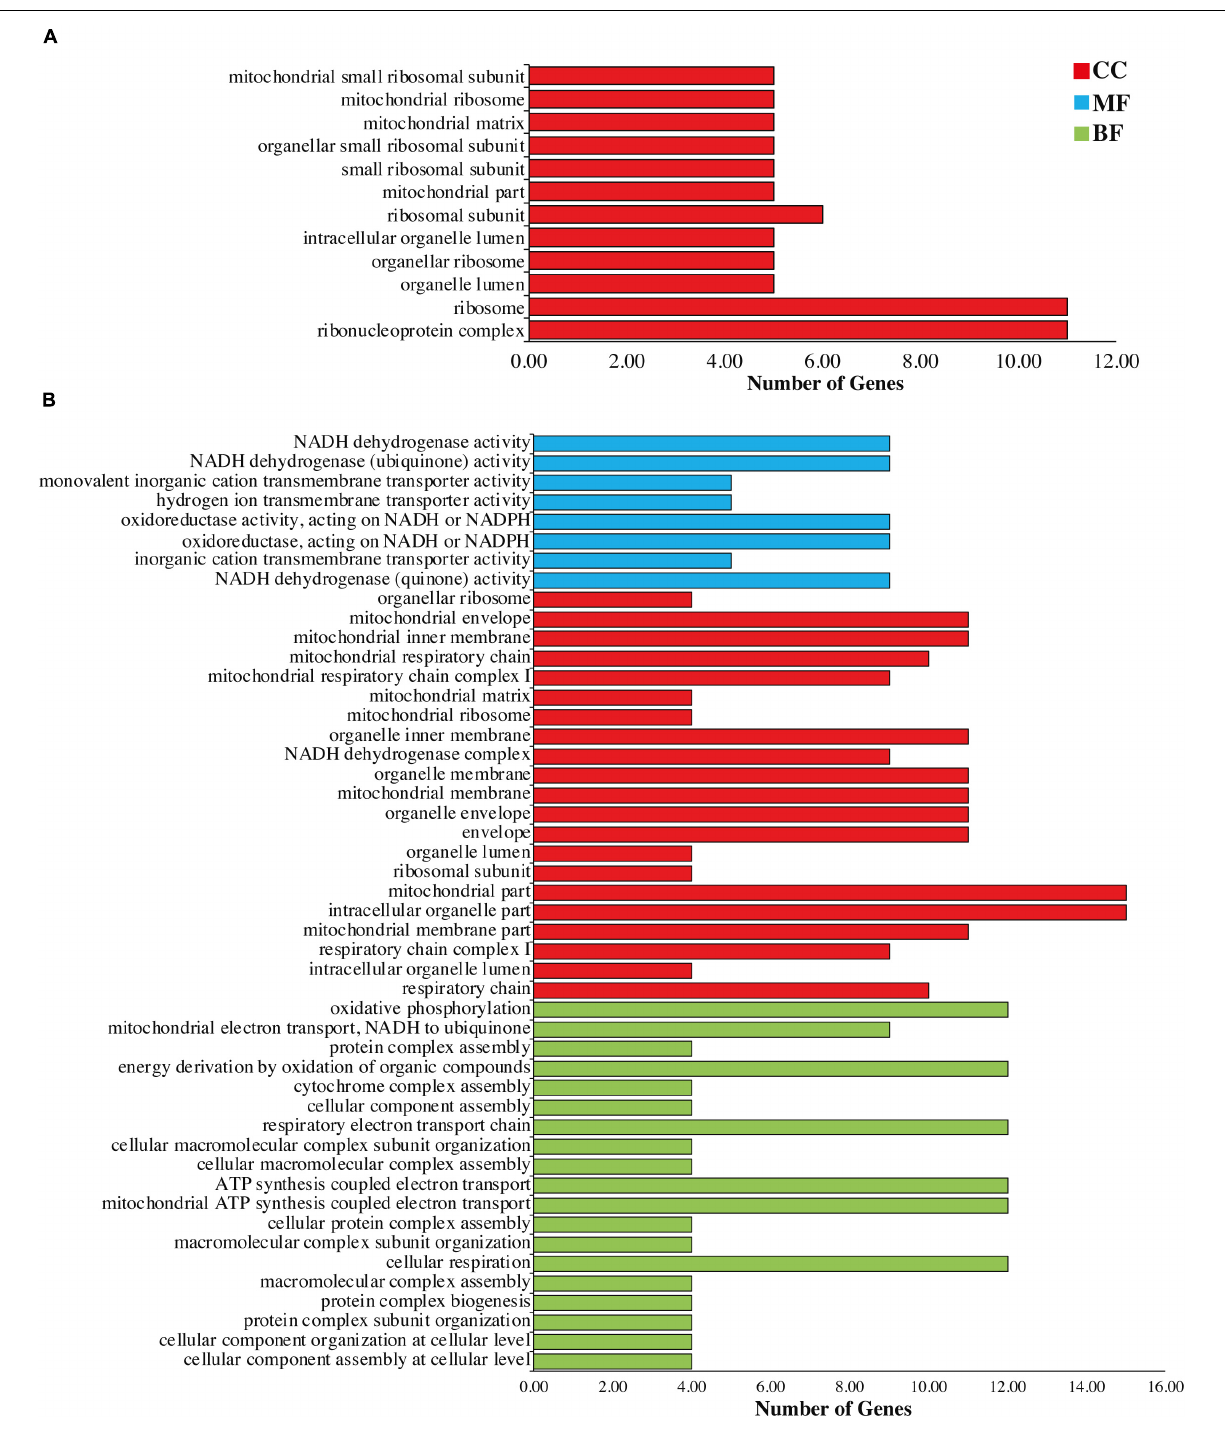
confirmation of molecular mechanism of this RNA editing